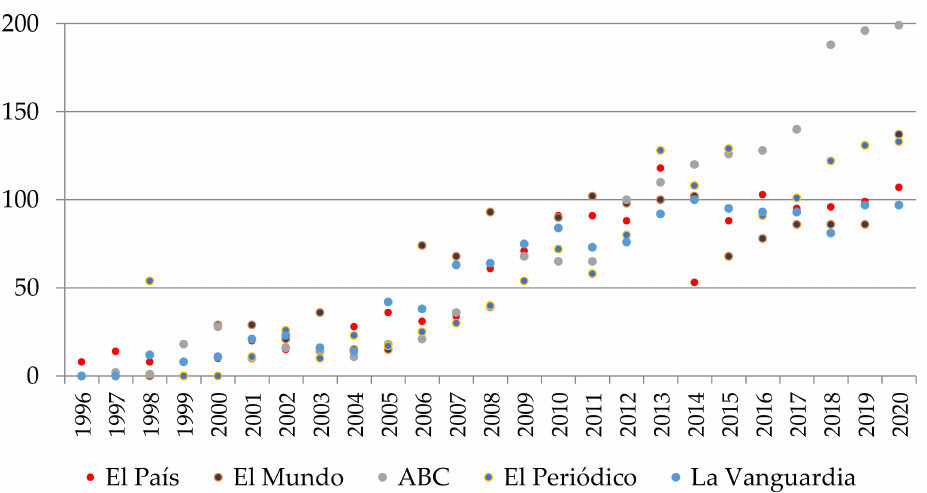
Figure 10. Number of news pieces on the front page of Spanish online media. Compiled by the authors.4.4. Front pages and SEO as access windows.